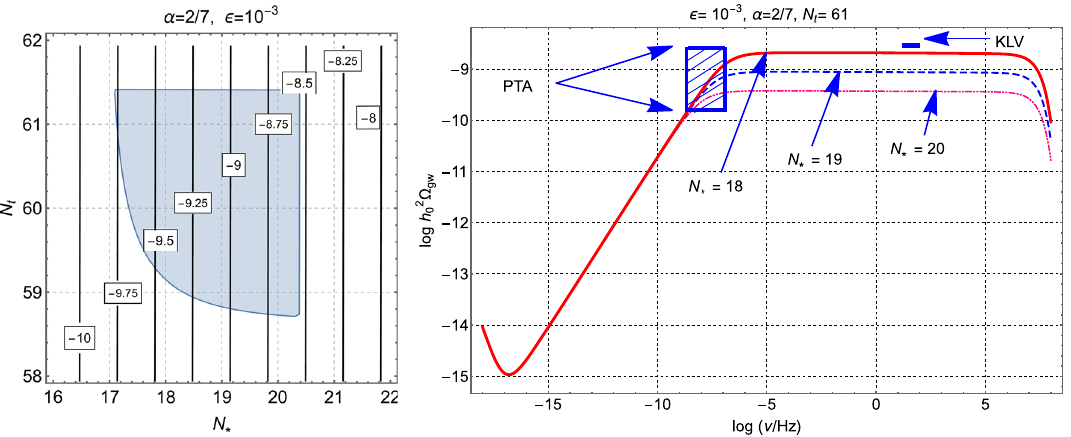
Fig. 3 In the plot at the left we compute the allowed region in the parameter space when α is fixed to 2 / 7. This choice implies that the chirp amplitude scales as ν − 2 / 3 while the spectral energy density goes as ν 2 / 3 . In the plot at the right we illustrate the spectral energy density